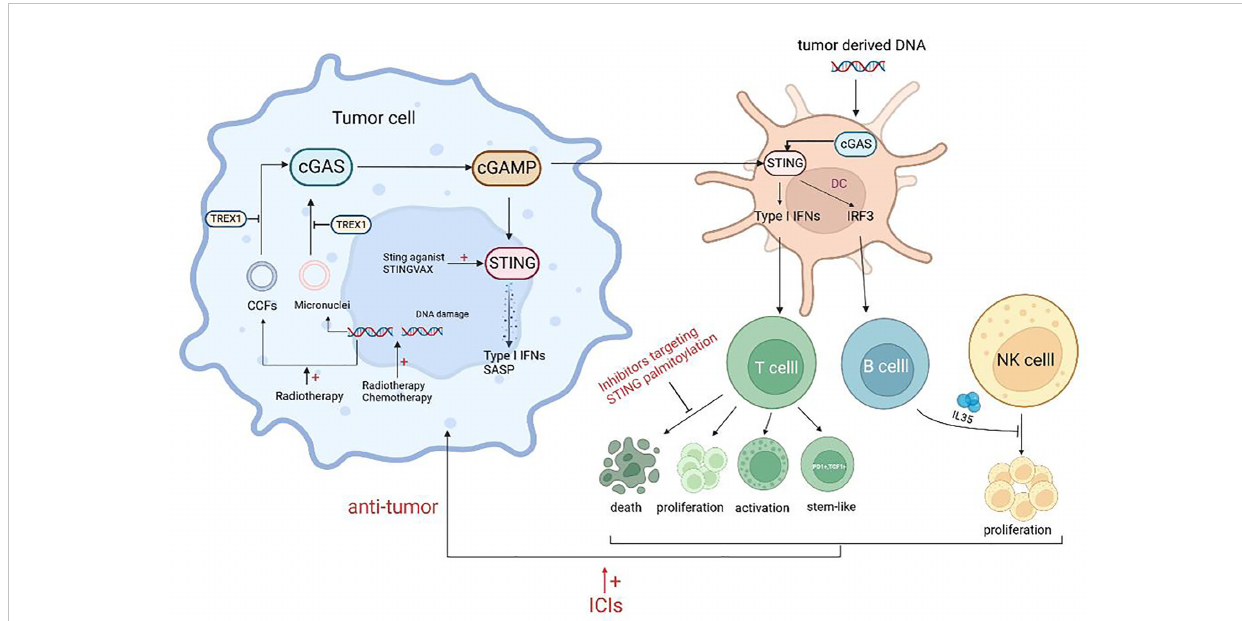
FIGURE 2 Schematic representation of the agonists of cGAS-STING and antitumor immunity. Treatment such as radiotherapy and chemotherapy can lead to DNA damage, resulting in increased free intracellular DNA and damaged chromatin, and lead to the formation of micronuclei which can activate the cGAS-STING pathway. Released in fl ammatory mediators act on T cells to promote the proliferation, activation, and stem-like changes of T cells. However, some STING agonists can promote the death of CTLs and the secretion of NK inhibitory factors by B cells, which is not conducive to antitumor immunity. Combining ICIs or targeting adverse effects will improve the ef fi cacy of STING